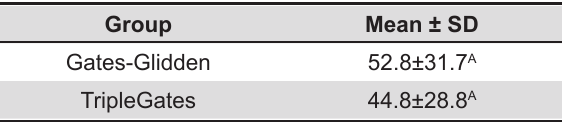
Same letters represent no statistically significant difference (p<0.05) Table 2- Means (mm) and standard deviation (SD) of dentin wall thickness on the initial and postinstrumentation images and percentage reduction in each group at the mesial and distal aspects of the root canal